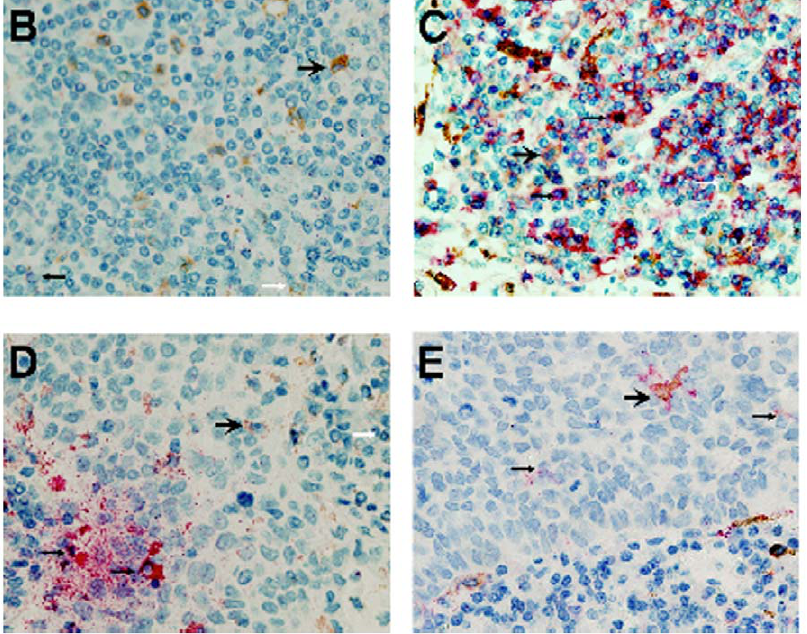
Figure 1. Immunohistology in NSCLC. In (A)–(E), CD68 + cells are stained brown and (A) CD163 (red), (B) VEGF (red), (C) HLA-DR (red), (D) iNOS (red) and (E) MRP 8/14 (red). Singlestain CD68 brown (white arrowhead), Singlestain non-macrophage phenotypic marker red (small arrowhead), Double-stain cells contain both brown and red (large arrowhead).